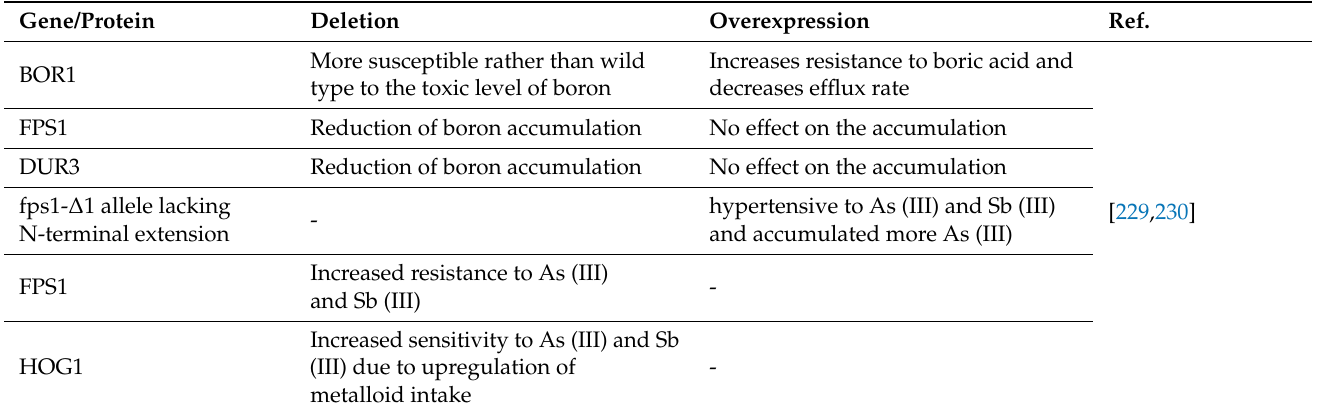
Table 3. Genes involved in metalloid uptake in S. cerevisiae